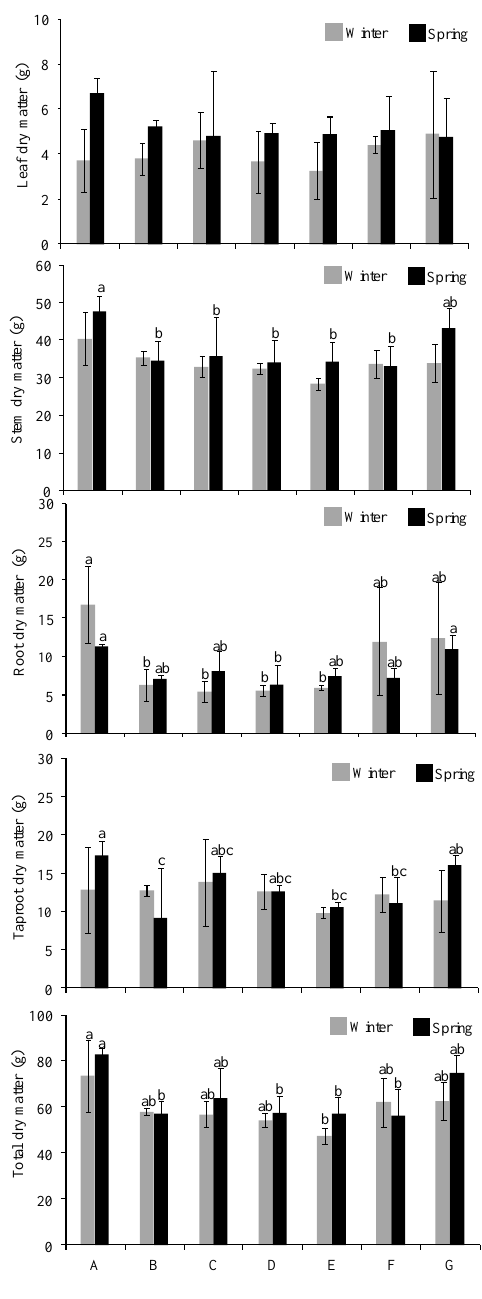
Figure 2. Dry matter distribution recorded in winter (February 2015) and spring (April 2015) of Carrizo citrange seedlings potted in di ff erent growing media. For each parameter and period ANOVA and mean separation by Tukey’s HSD test ( p ≤ 0.01; bars represent standard deviation). The b and c letters above di ff erent bars indicate significant di ff erences compared to the letter a. a Growing media was 50% sandy soil + 50% the following: A = black peat and perlite 1:1; B = biochar 1; C = black peat, perlite, and biochar 0.5:1:0.5; D = black peat and biochar 1:1; E = black peat, compost, and biochar 0.5:0.5:1; F = black peat, perlite, compost, and biochar 0.5:0.5:0.5:0.5; G = black peat and lapillus 1:1 (control, mixture adopted by the hosting